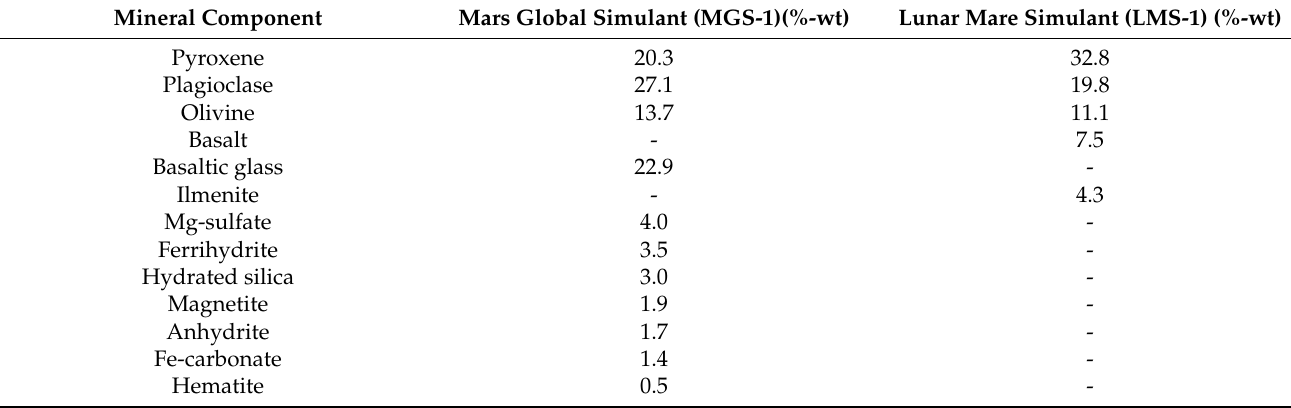
Table 2. Mineral composition of Martian and lunar regolith simulants used in this study (source: ExolithLab). Mineral